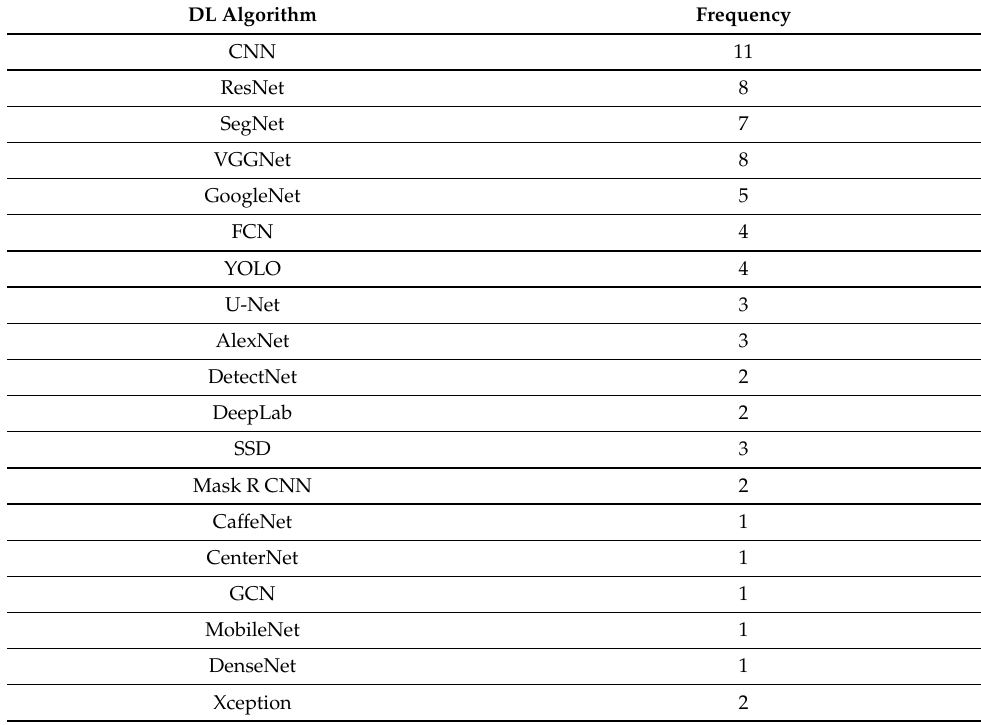
Table 5. Frequency Distribution of CNN Variants.